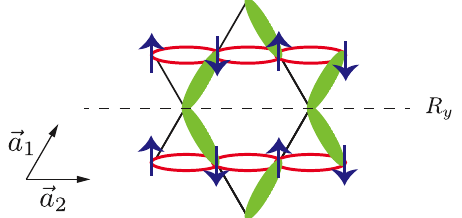
Q ð 2 S x Þ ⃗ S ⃗ S i , to be i · j